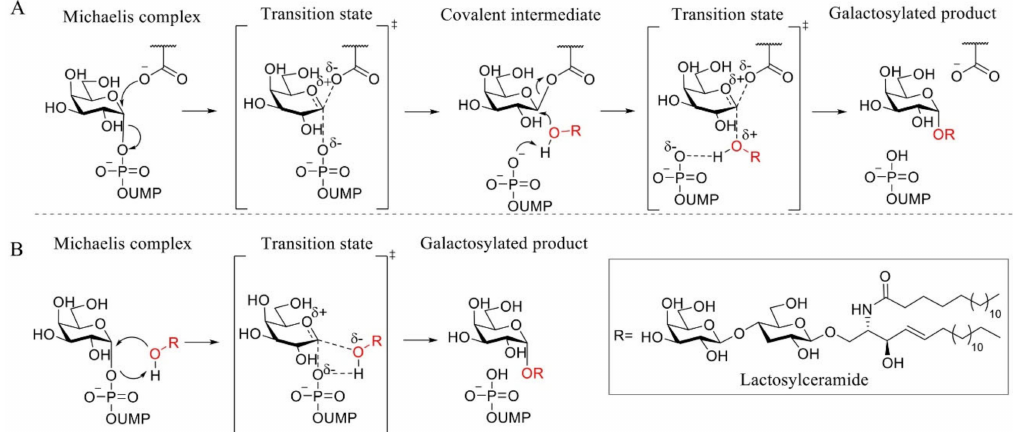
Figure 5. Proposed A4GALT mechanisms. ( A ) Koshland double displacement mechanism of retaining glycosyltransferases (GTs). ( B ) Front-face (S N i-like) mechanism of retaining